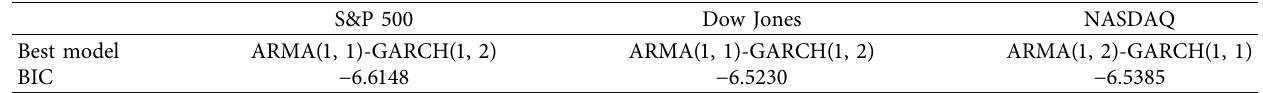
Table 2: ARMA-GARCH model with minimum BIC.